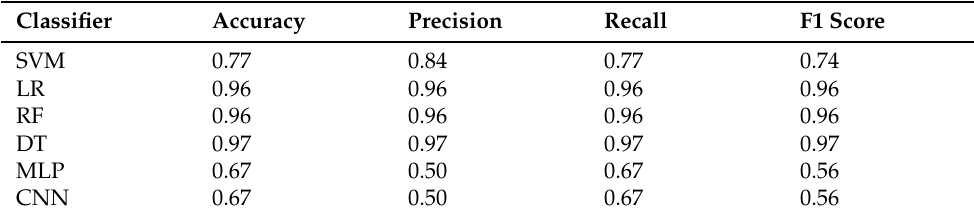
Table 5. Results of machine learning and deep learning classifiers using 80–20 train–test split.